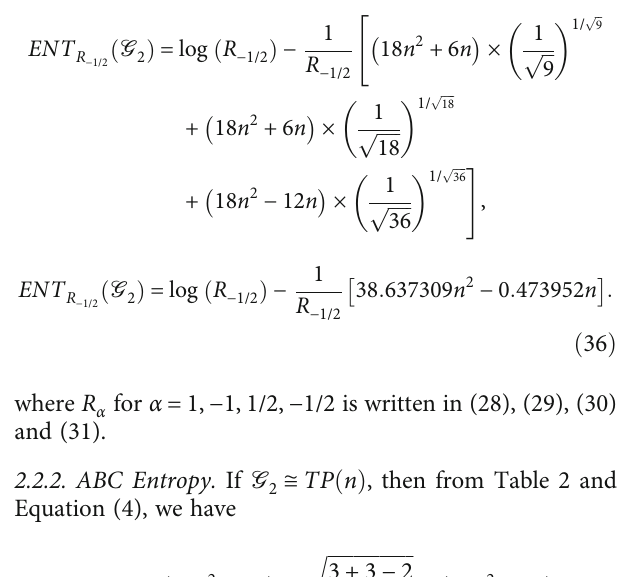
ffiffiffiffiffiffiffiffiffiffiffiffiffiffiffiffiffi ! ffiffiffiffiffiffiffiffiffiffiffiffiffiffiffiffi